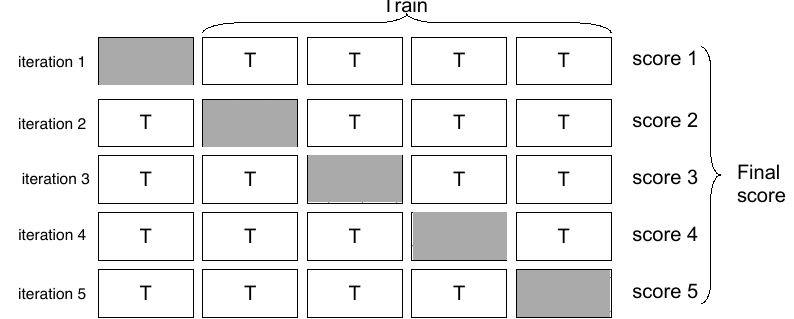
Figure 4. 5-fold cross-validation to optimise the performances of the resulting